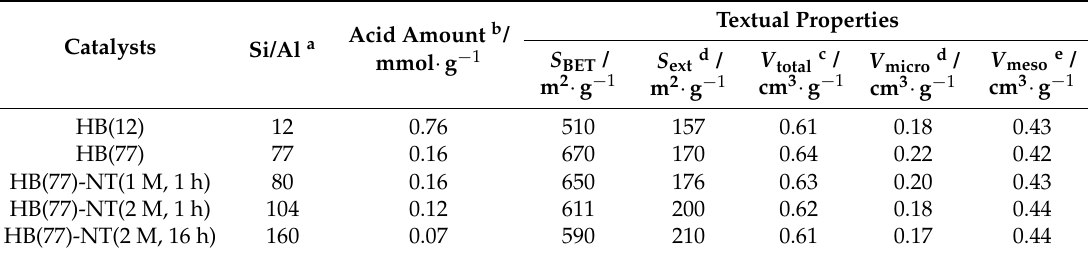
Table 1. Physicochemical properties of HB(12), HB(77) and acid-treated HB catalysts.